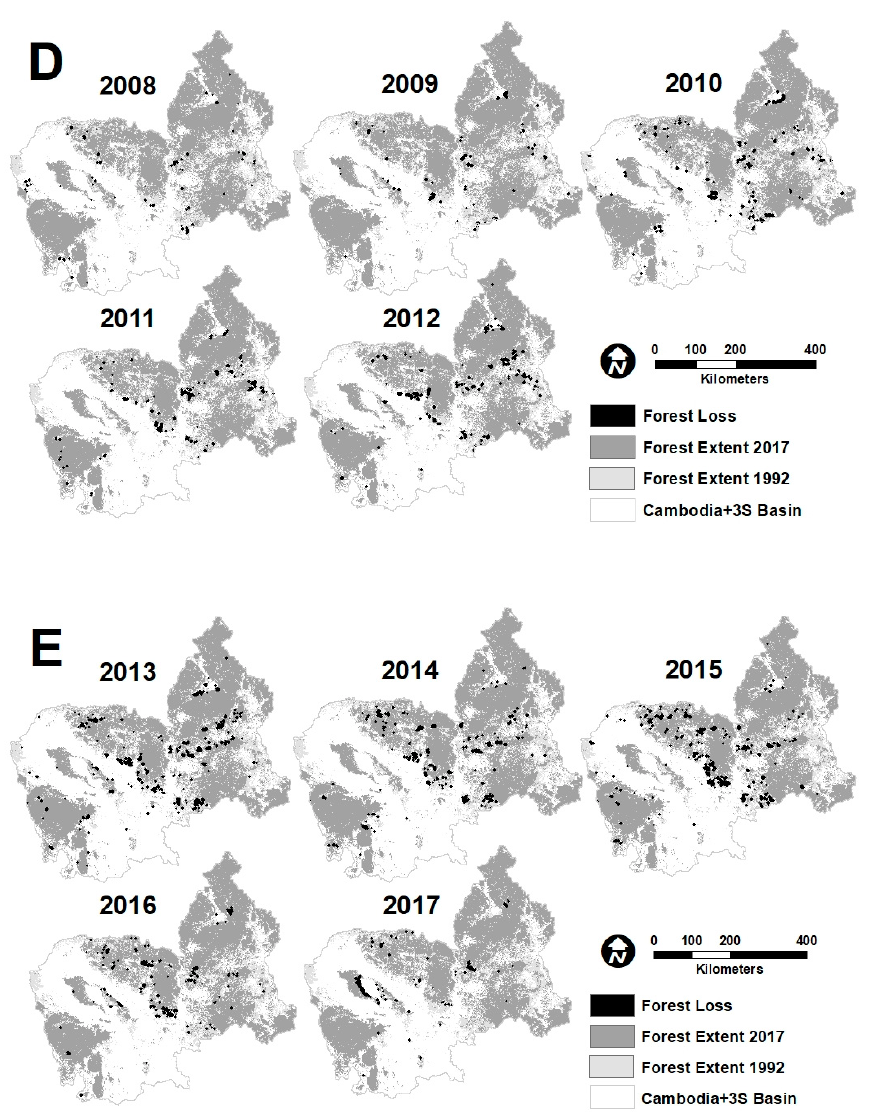
FigureA2. ForestlossinCambodiaandthe3SBasinforindividualyearsfrom1993–1997( A ),1998–2002 ( B ), 2003–2007 ( C ), 2008–2012 ( D ), and 2013–2017 ( E Figure A2. Forest loss in Cambodia and the 3S Basin for individual years from 1993–1997 ( A ), 1998– 2002 ( B ), 2003–2007 ( C ), 2008–2012( D ), and 2013–2017 ( E ).